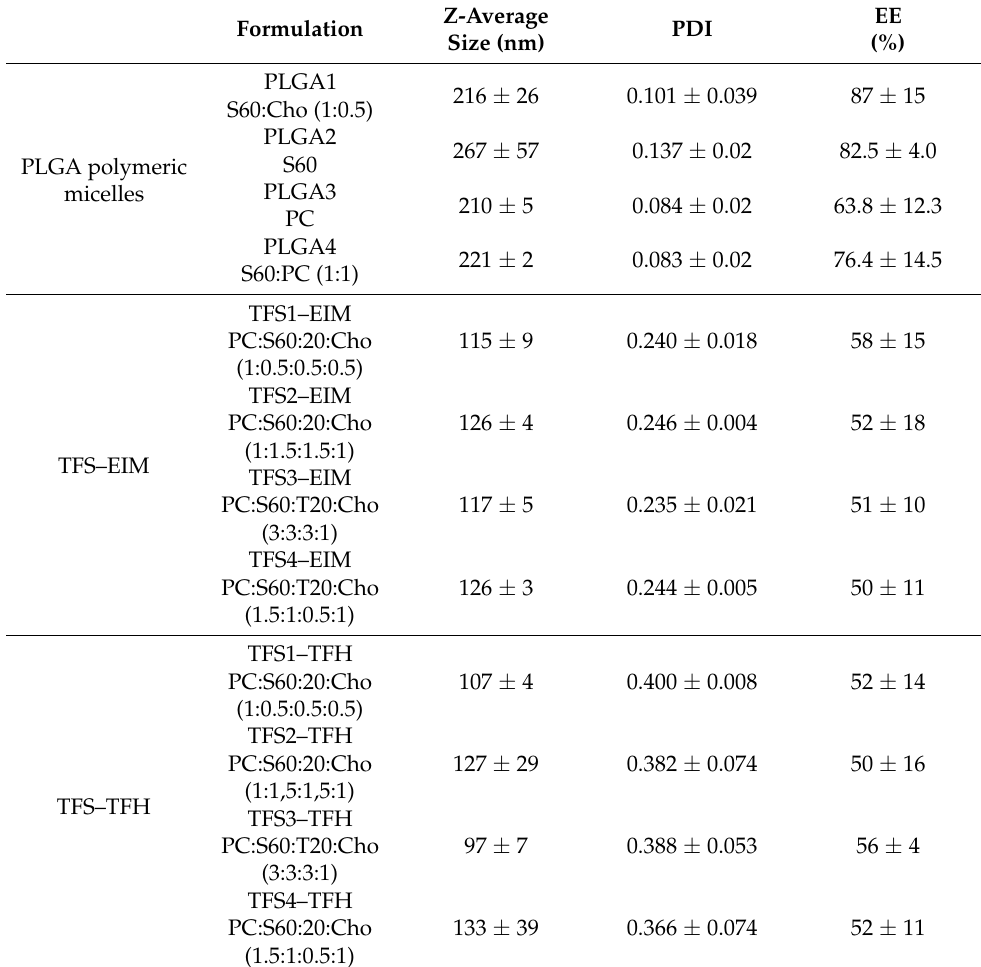
Table 1. Polymeric micelles and transfersomes size (nm) in terms of Z average, intensity and number, polydispersity index (PDI), encapsulation efficiency